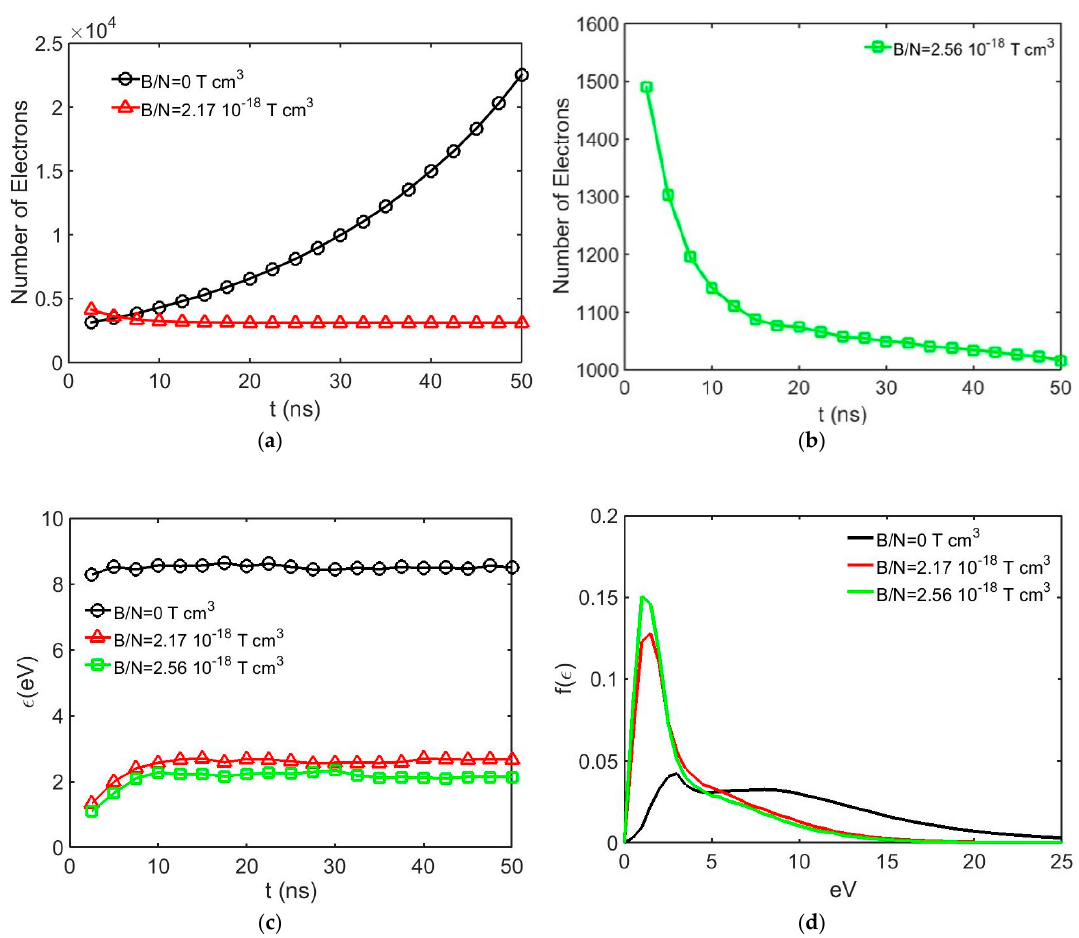
Figure 9. A 0.50% SF 6 + 99.50% N 2 mixture at 400 Td with different magnitudes of crossed magnetic field: ( a,b ) number of electrons; ( c ) electron mean energies; ( d ) electron energy distribution functions (Corresponding magnetic field strength; Black line: H = 0 A/m, Red line: H = 5.73 × 10 4 A/m, Green line: H = 6.76 × 10 4 A/m).